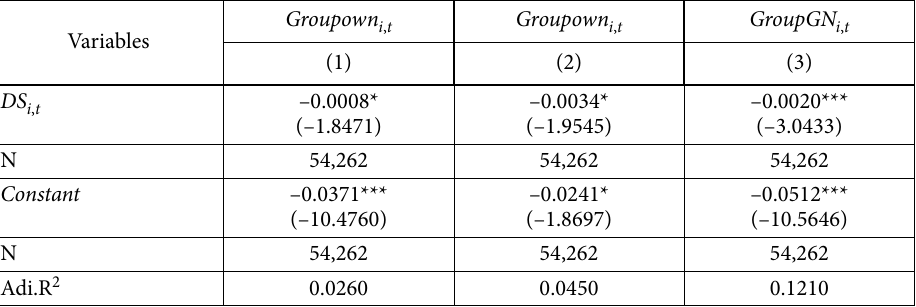
Table 10. Institutional investor approval clustering algorithm adjustment and listed company strategy deviation algorithm adjustment test